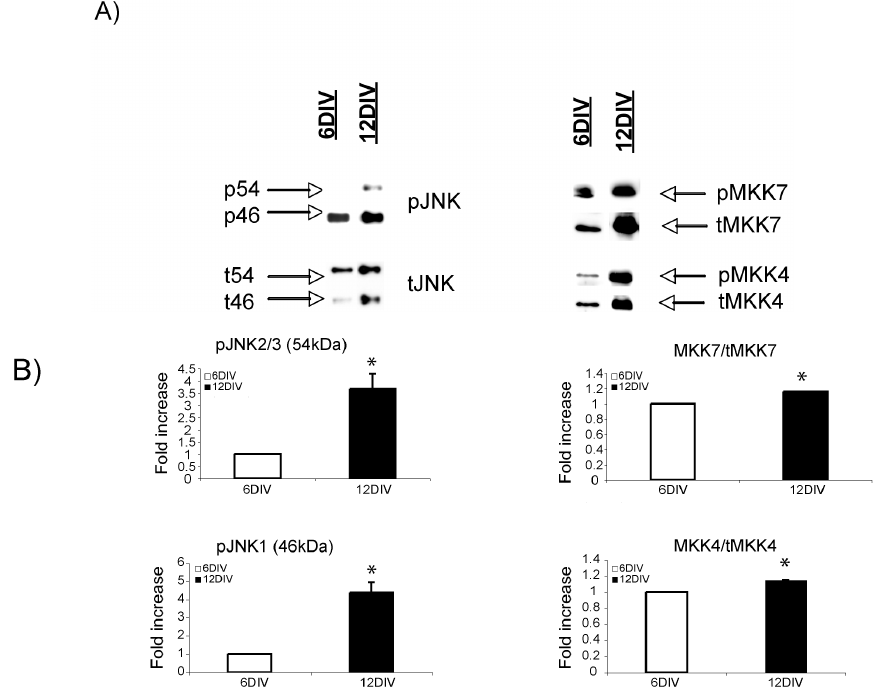
Figure 2. Basal levels of JNK signaling proteins increase with increasing age, while Hif- 1 α hypoxic induction decreases. (A) Representative Western blot images of phospho-JNK (pJNK), and its regulators pMKK7 and pMMK4 in 6DIV and 12DIV neurons. Basal levels of pJNK, pMKK7 and pMKK4 are higher in adult 12DIV neurons. (B) Quantification confirms significant up regulation of the JNK signaling components with increasing age (p < 0.05). (C) Representative Western blot images of Hif-1 α hypoxic induction in 6DIV and 12DIV neurons. (D) Quantification of Western blots shows that Hif-1 α hypoxic induction is 0.4 fold ± 0.086 lower in 12DIV adult neurons (p < 0.05). Data are presented as fold increase in comparison to normoxic controls. Quantification is from three independent